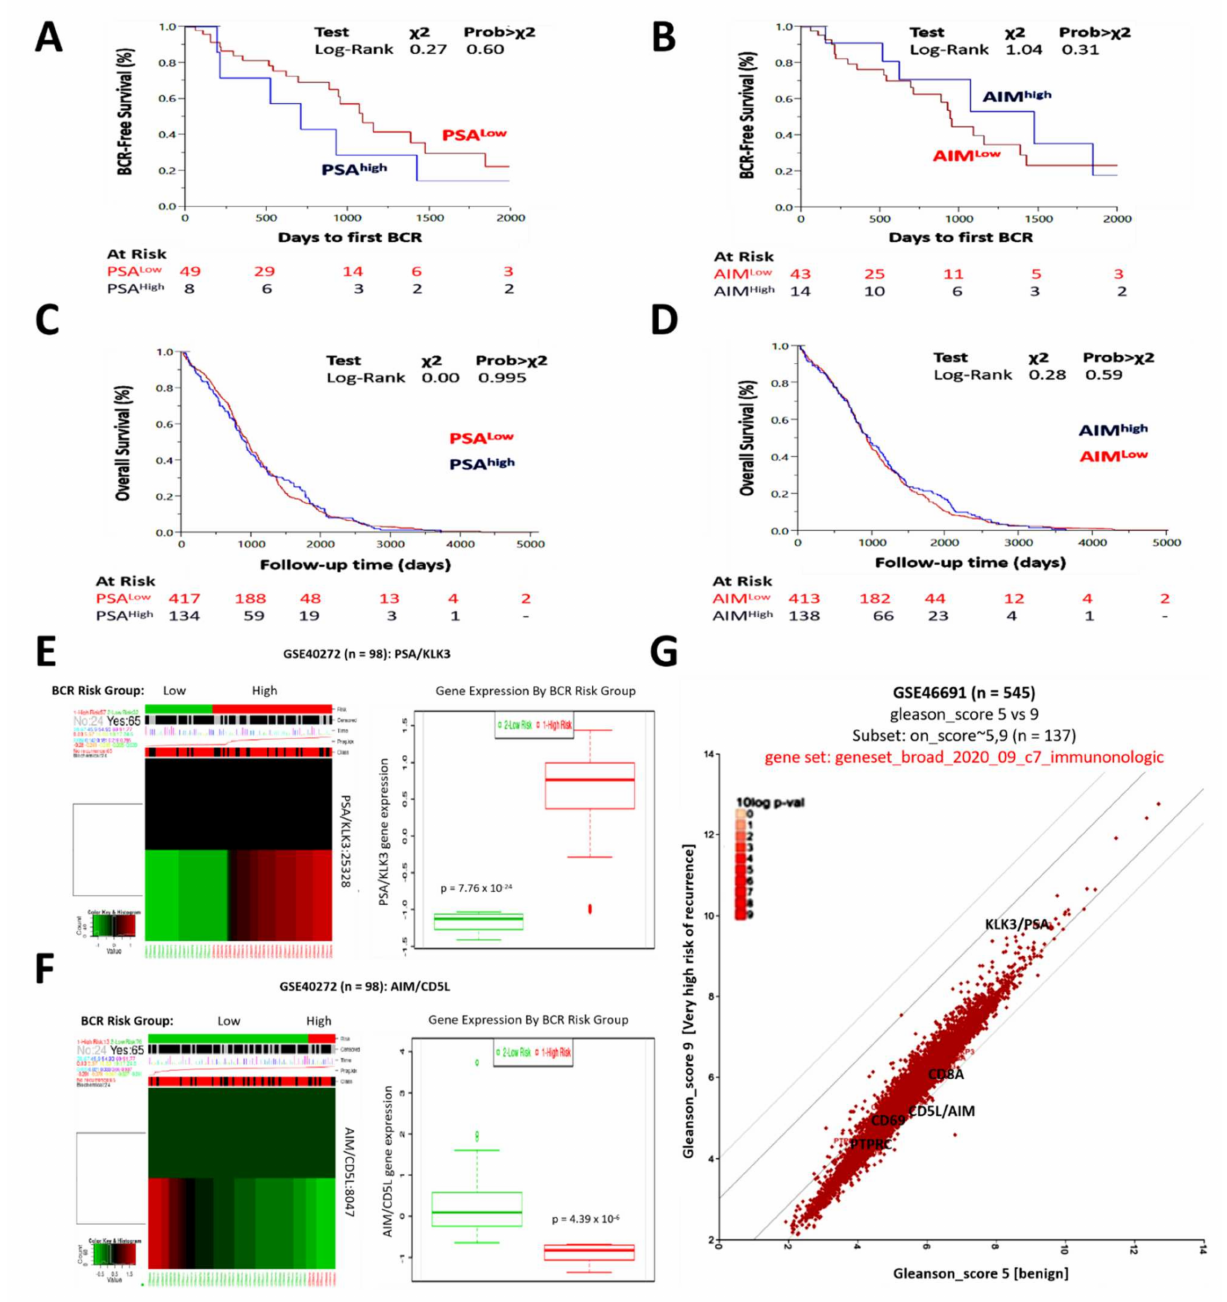
Figure 3. The differential expression of PSA and AIM is associated with disease recurrence in patients with prostate cancer but is equivocal for overall survival. Kaplan–Meier curves showing the effect of high or low ( A ) PSA and ( B ) AIM expression on BCR-free survival in the TCGA PRAD cohort. Kaplan–Meier curves showing the effect of high or low ( C ) PSA and ( D ) AIM expression on overall survival in the TCGA PRAD cohort. BCR risk group-stratified heatmap ( left ) and box-and-whisker plots ( right ) of ( E ) PSA/KLK3 or ( F ) AIM/CD5L expression levels in the GSE40272 cohort. ( G ) XY plot showing the differential expression of AIM and PSA in the GSE within the Broad_2020_09_c7_immunologic gene set. BCR, biochemical recurrence; TCGA, the cancer genome atlas; PRAD, prostate